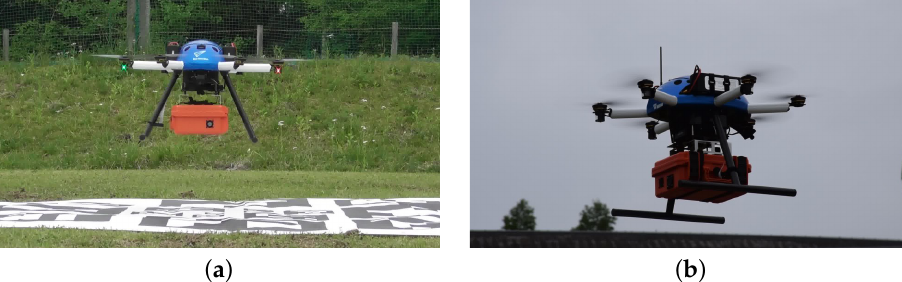
Figure 8. Demonstration test of the drone-based message ferry. ( a ) Take-off of a drone attached with LACS. ( b ) Drone attached with LACS in the